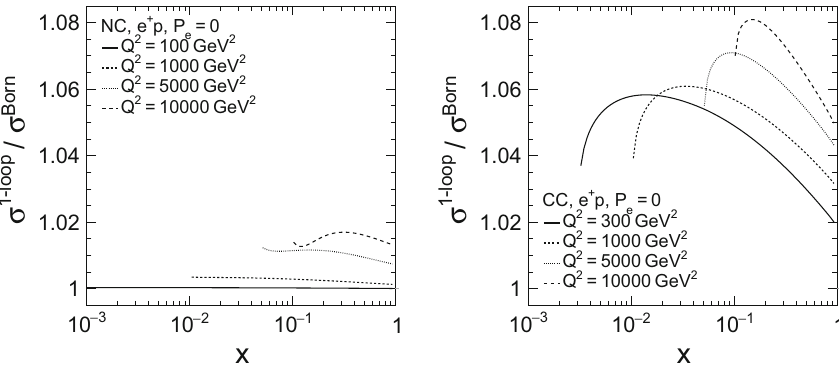
running of α ) are not included. The corrections for electron scattering and for the case of non-vanishing lepton beam polarisation are all very similar to the positron case, such that they differ by less than 0 . 01